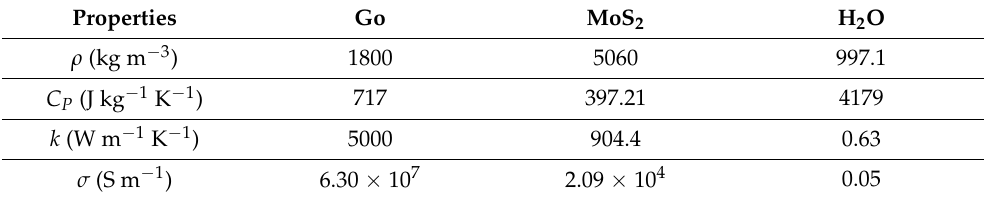
Table 1. The thermophysical properties. (refer to Waini et al. [6] and Raza et al. [30]). Properties